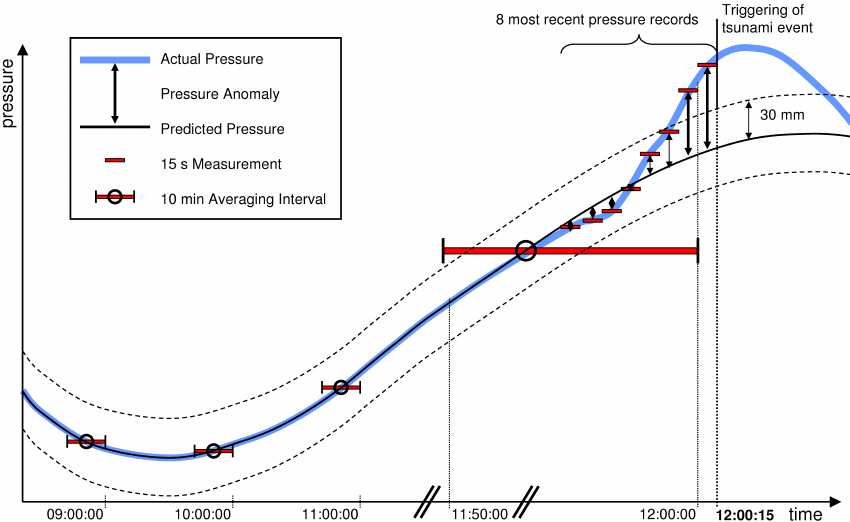
Fig. 9. Sketch illustrating the tsunami detection algorithm (Mofjeld, 1997). The solid curves show the actual (heavy blue line) and predicted (thinner black line) pressures based on four 10-min averages (horizontal bars). Note that the time axis is not to scale, zooming into the last 10min and 2min intervals. In this example, the two most recent 15-s records (horizontal short red bars) starting at 11:59:45 exceed the 30mm anomaly threshold (dashed lines), triggering the tsunami mode at